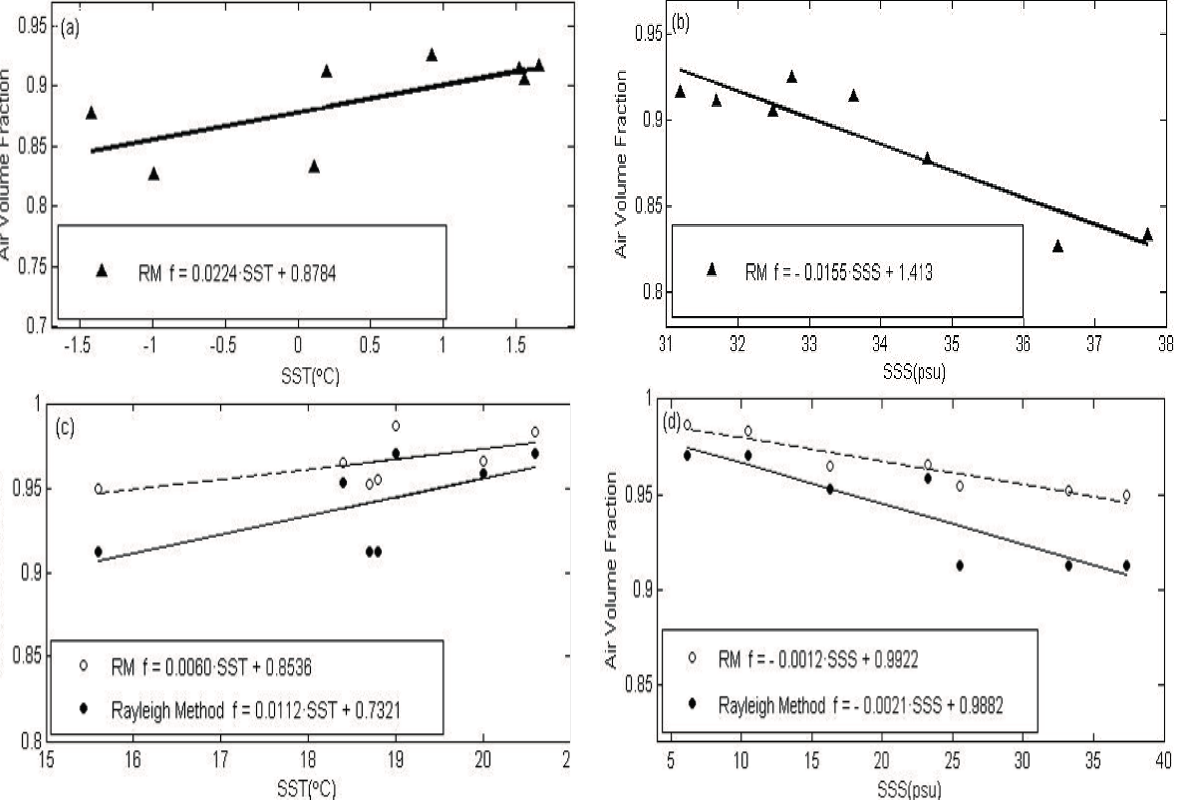
Figure 3. Air volume fraction (AVF) of foam layer versus SST and SSS: ( a ) AVF obtained by RM emissivity model in our experiments versus SST; ( b ) AVF obtained by RM emissivity model for our experiments versus SSS; ( c ) AVF obtained by RM emissivity model and Rayleigh method from Camps’ experiments [6] versus SST; ( d ) AVF obtained by RM emissivity model and Rayleigh method from Camps’ experiments [6] versus